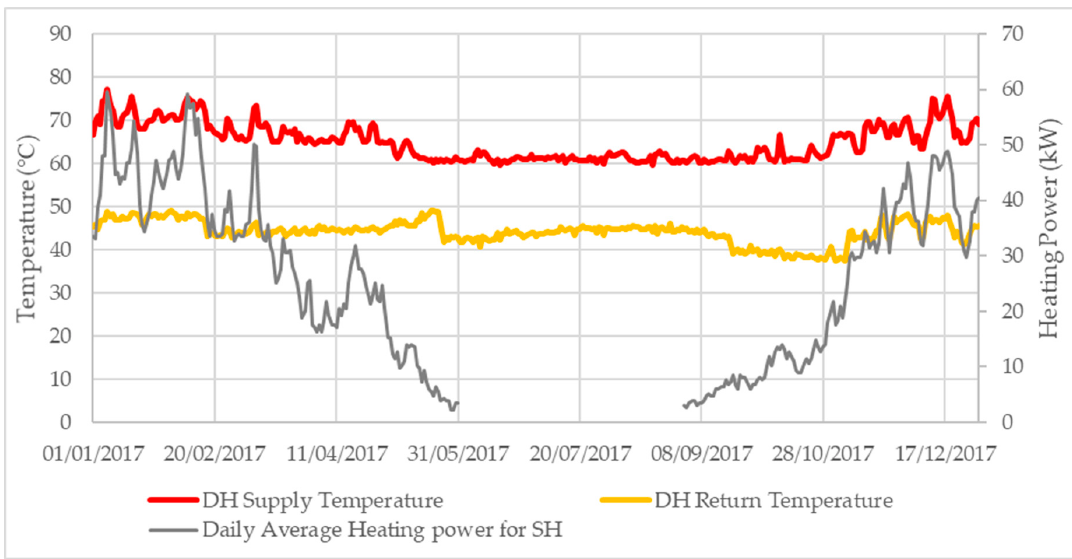
Figure 3. The daily average direct heating (DH) supply and return temperature along with the daily average energy use for space heating (SH), measured by the energy meter in the substation of the building case study, during 2017.